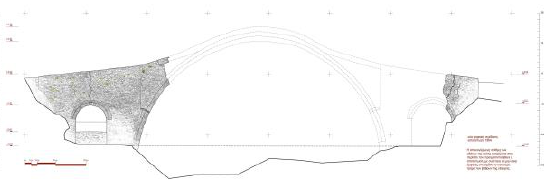
Figure 6. South façade plan of Plaka Bridge after the